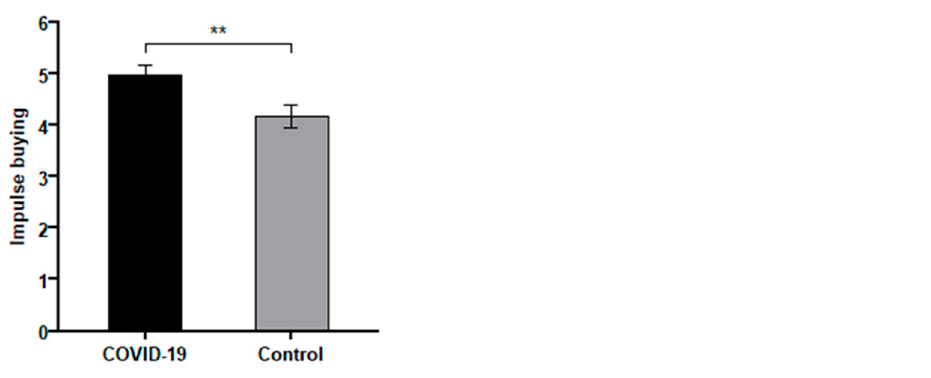
Figure 2. The impact of the COVID-19 pandemic on impulse buying (Study